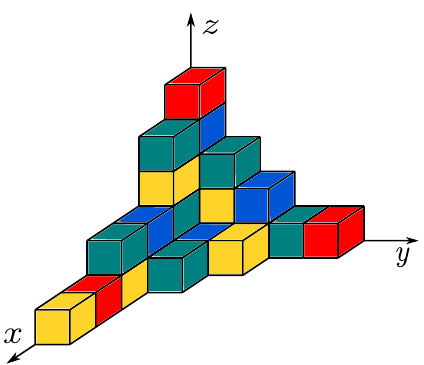
Figure 11. Quiver diagram and three-dimensional crystal of C 3 / ( Z 2 × Z 2 ) . The three-dimensional crystal is a plane partition, which is the same as the quantum toroidal gl different. There are four colors: red, blue, yellow, green. Each of them corresponds to the four vertices of the quiver diagram. The origin box is red.